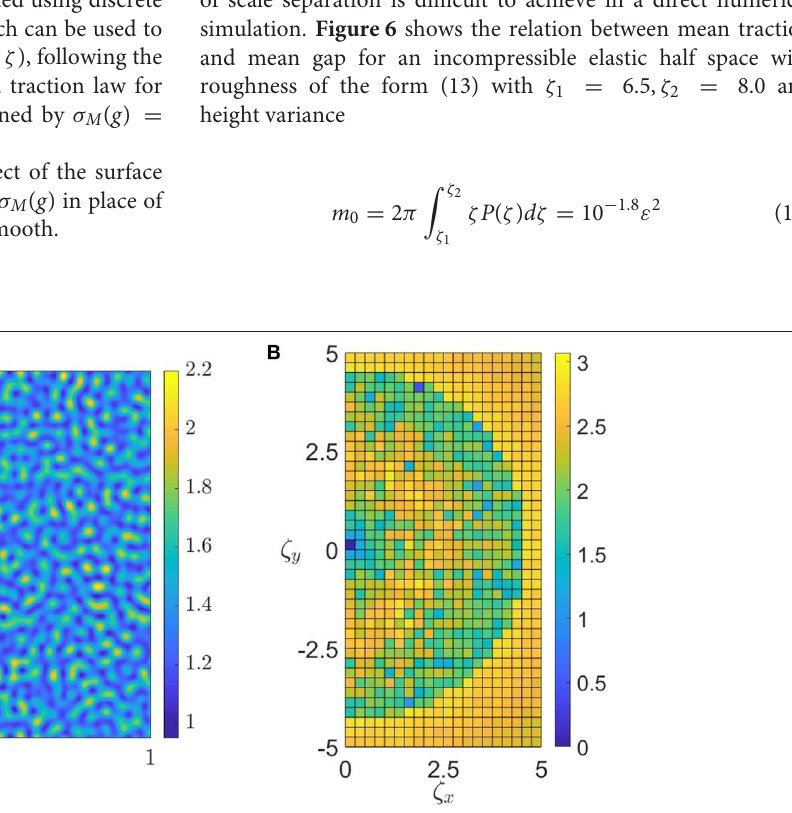
4.5, ζ 2 8 and m 0 10 − 2 ε 2 . (B) Fourier domain plot for = = =